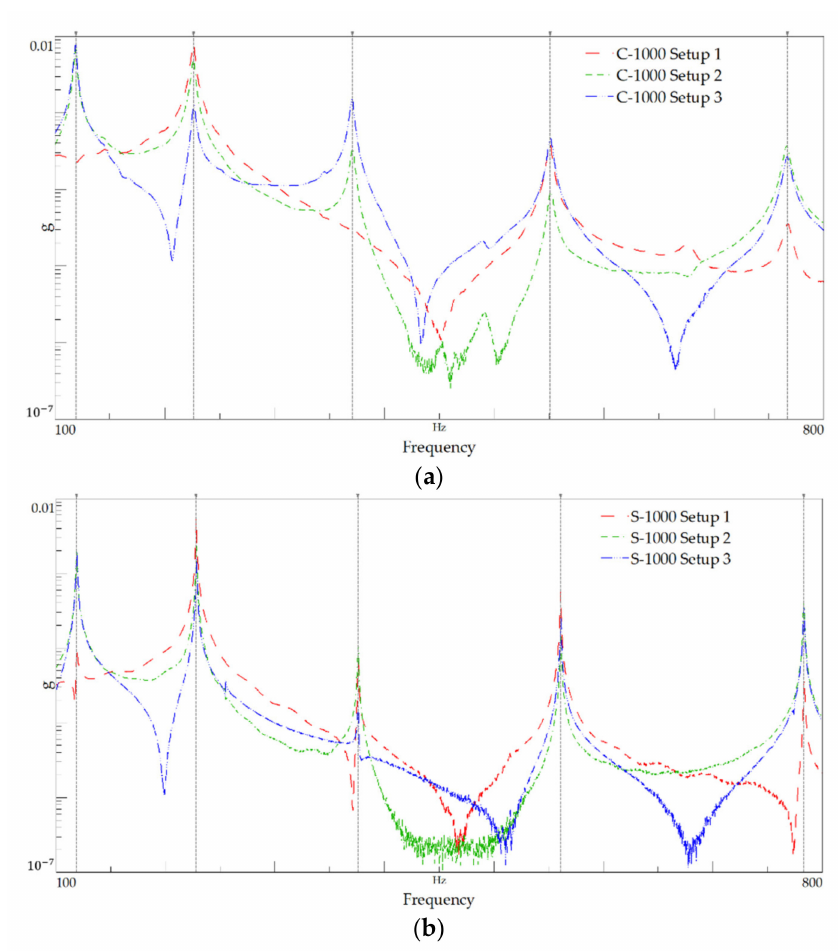
Figure 11. Power spectral density plot for the 1000 mm-length: ( a ) C-1000 and ( b ) S-1000.